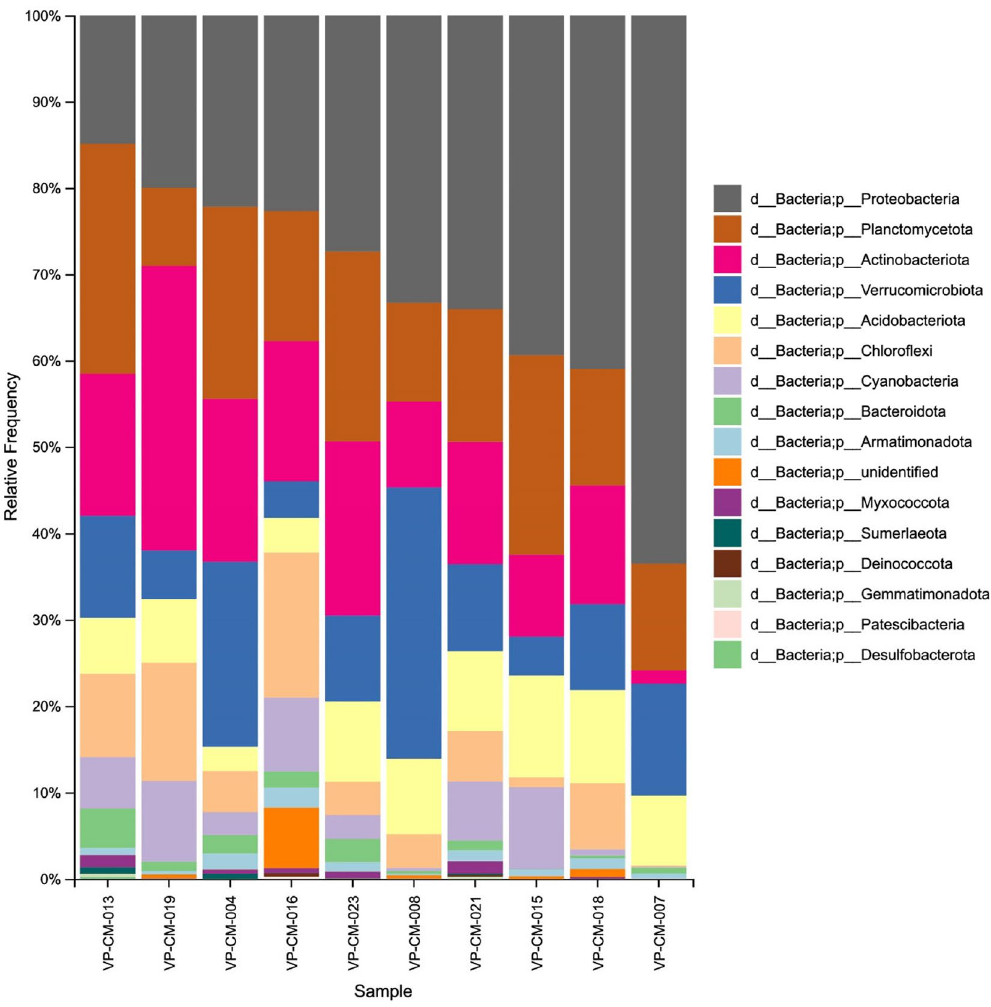
Figure 3. Taxa bar plot representing the relative abundance of bacterial phyla from 10 lichen